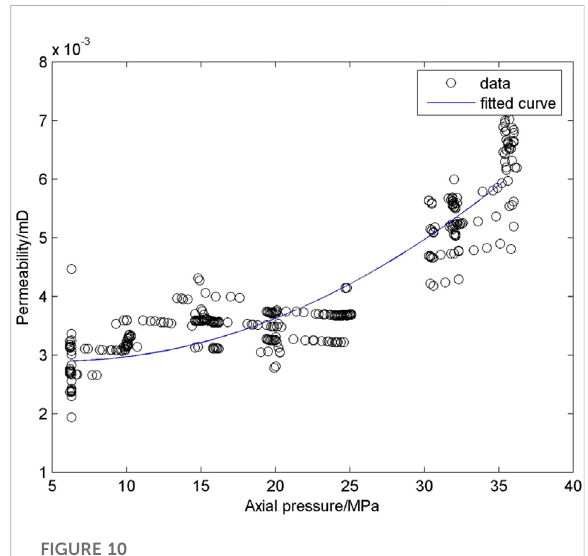
FIGURE 10 Polynomial fi tting between axial pressure and